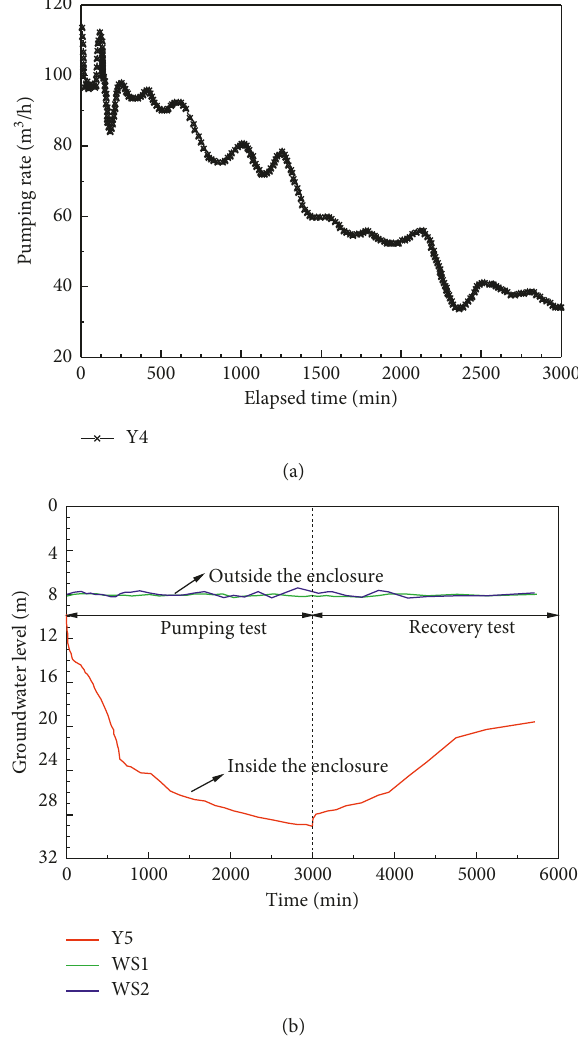
Figure 3: Time-history curves of the pumping test. (a) Pumping rate. (b) Variation of